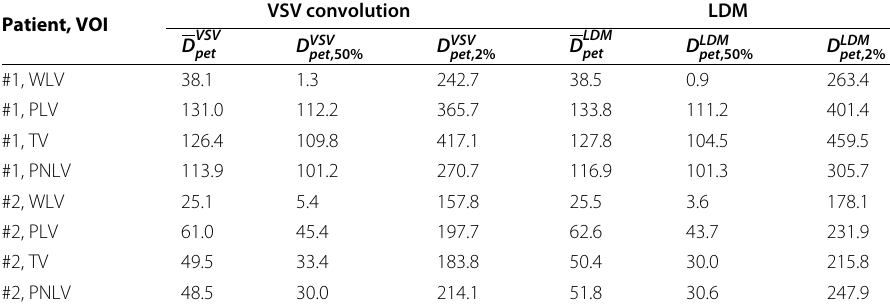
Table 5 Comparison of LDM to VSV convolution absorbed dose calculation methods through D mean , D 50% and D 2% for patients #1 and #2 and different VOIs. Reconstructions were performed